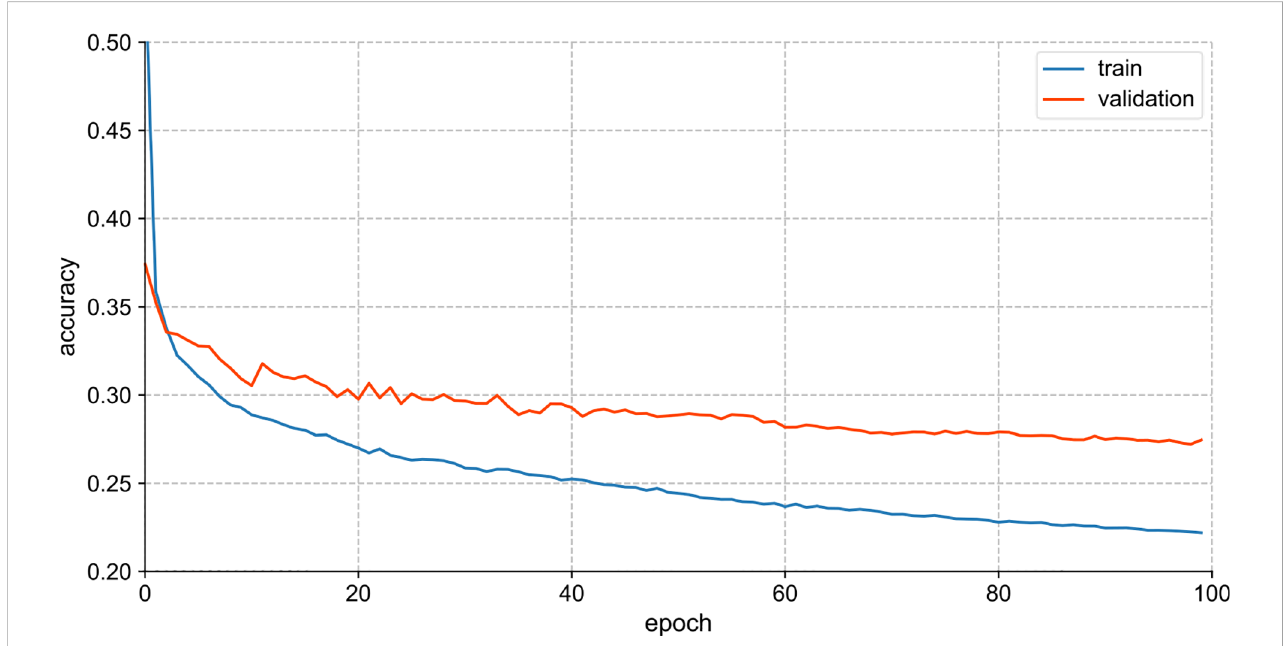
FIGURE 4 Accuracy and loss curves of training set and veri fi cation set (Vanila LSTM